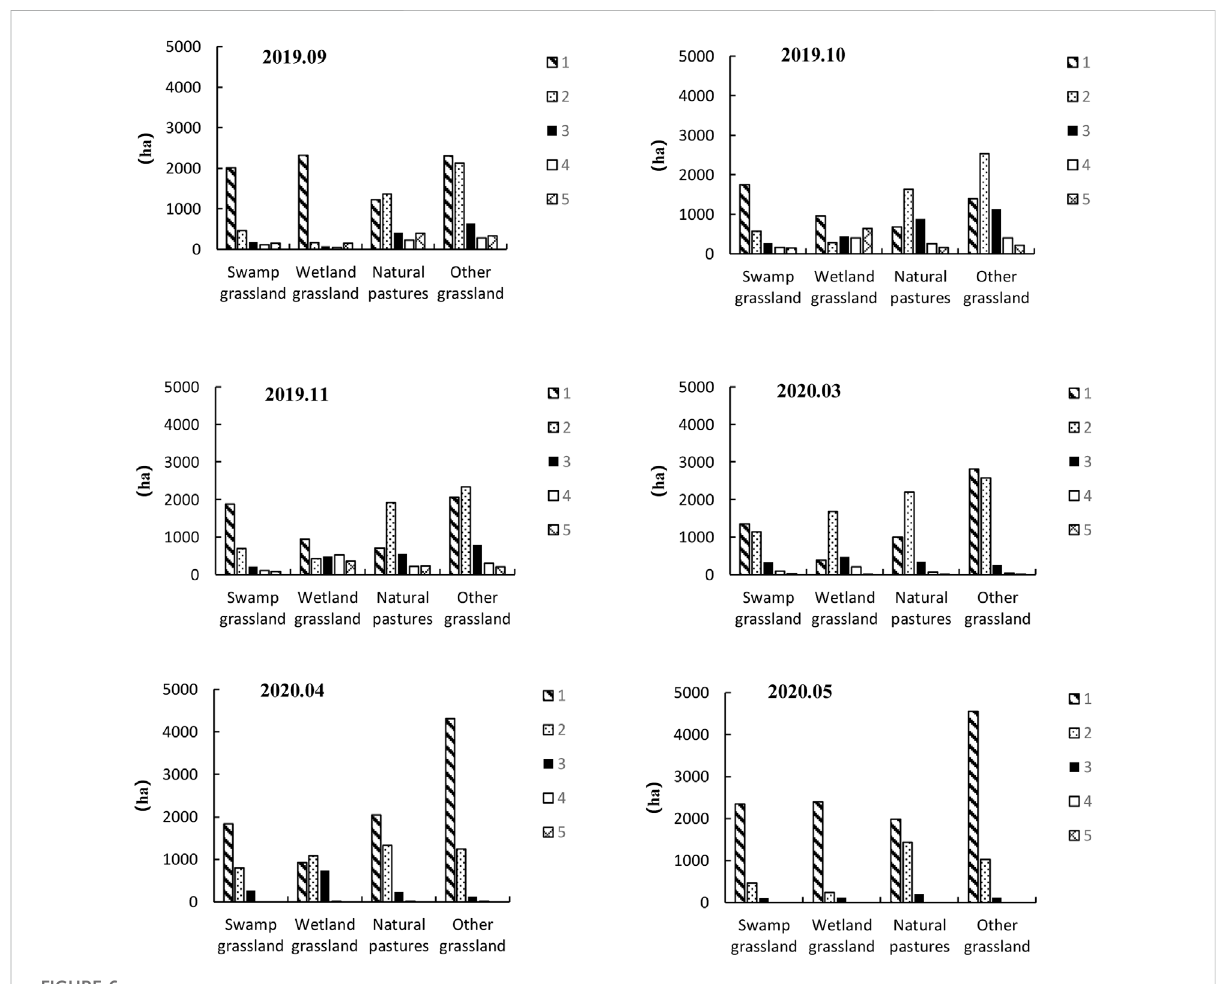
FIGURE 6 Monthly dynamic distributions showing the quantity of combustible